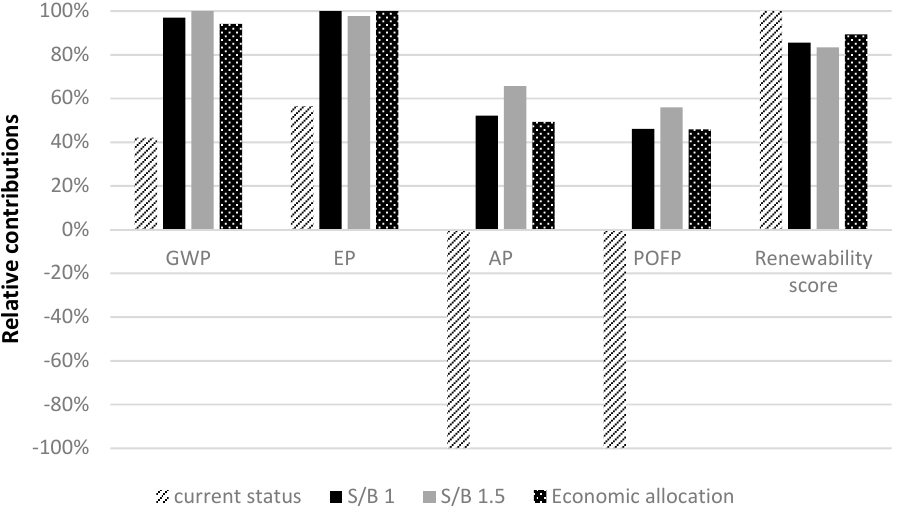
Figure 8. Sensitive analysis results for increase in hydrogen production.